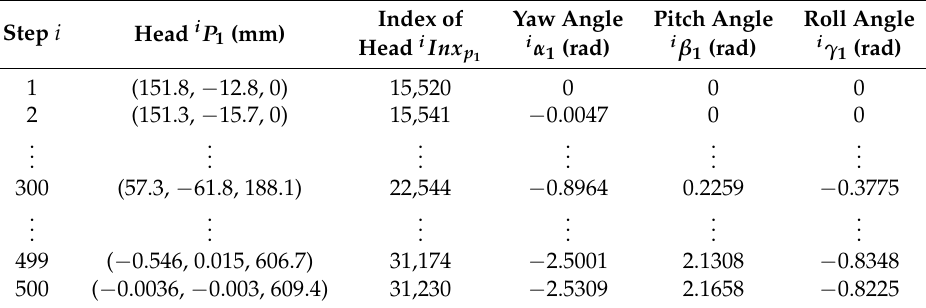
Table 1. Data during phase-shifting